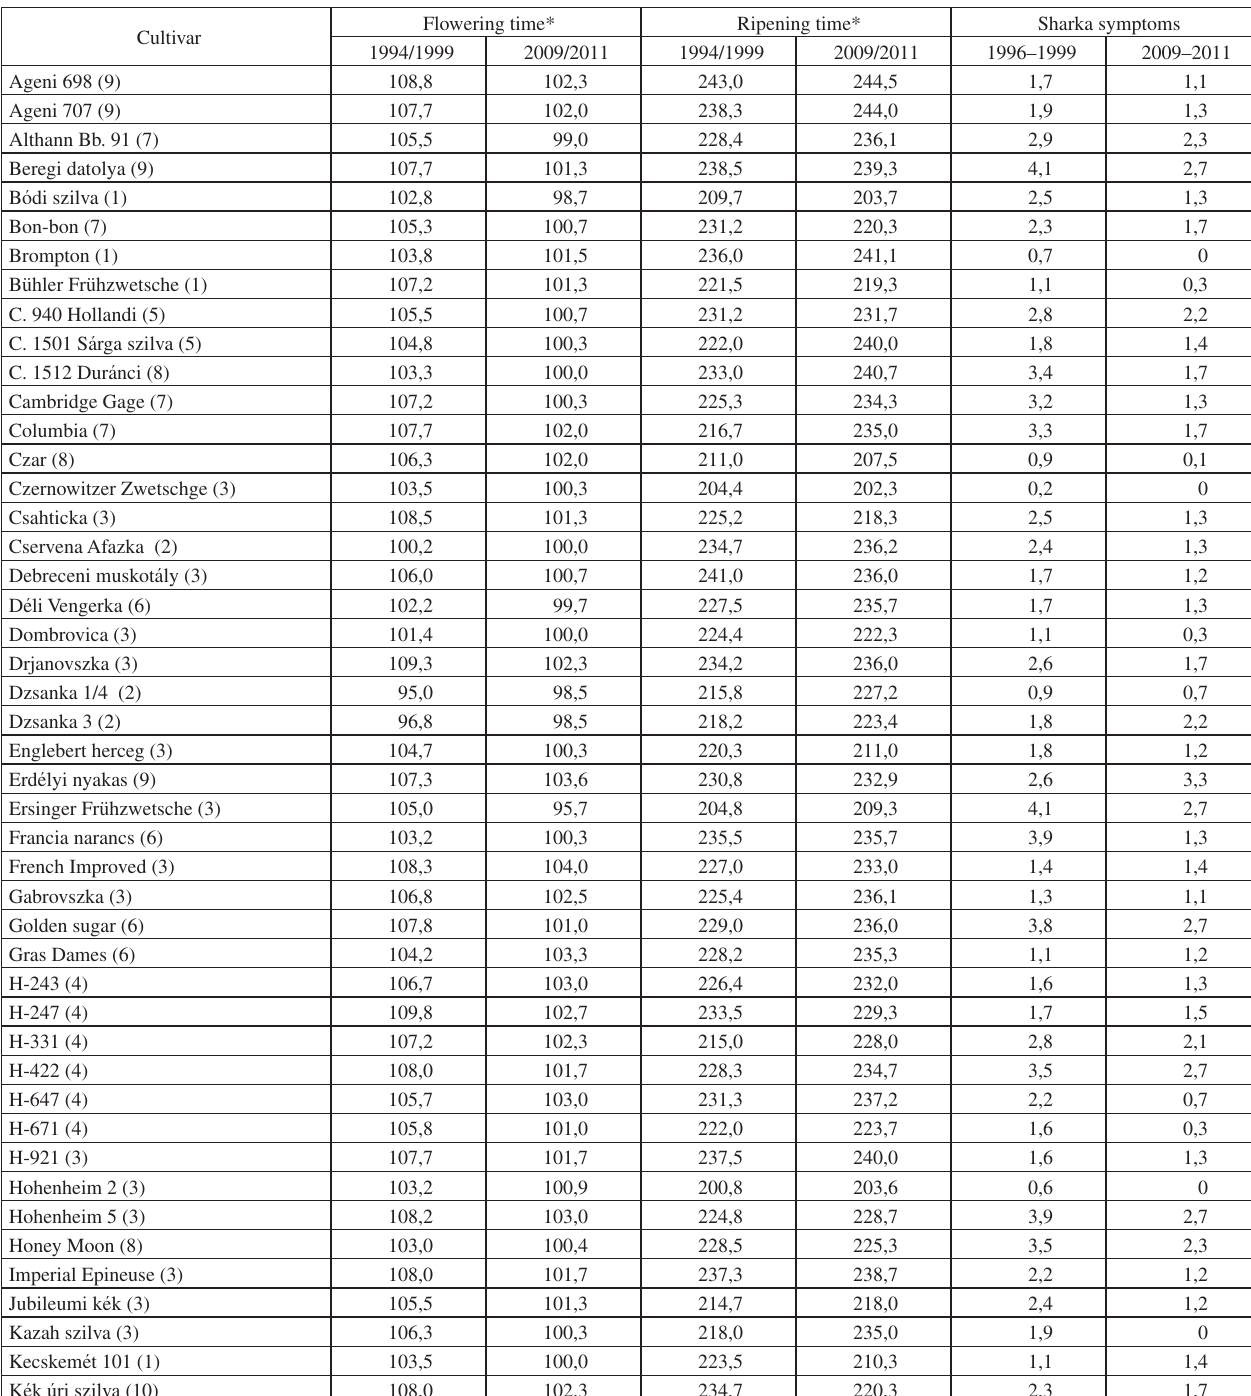
Table 2. Characterization of plum and prune cultivars with phenological and sharka symptom traits *Note : From the fi rst day (days) Flowering time* Ripening time* Sharka Cultivar